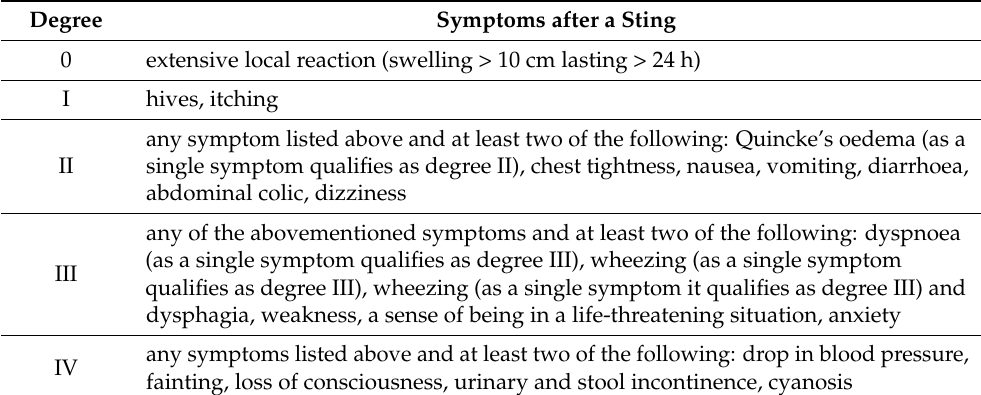
Table 2. Severity degree of allergy to Hymenoptera venom according to Mueller scale